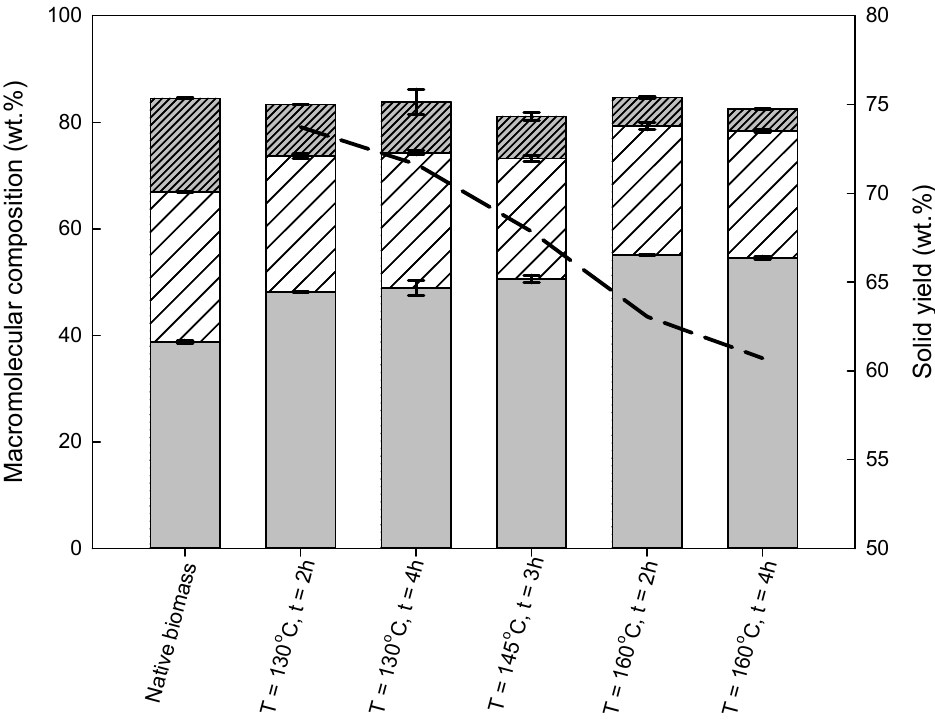
Figure 2. Native wheat straw and solid fraction compositions (wt %), obtained from pre-treatment with imidazole at varied reaction temperatures and times. The black line represents the recovered solids (wt %). The cellulose amount, depicted as a grey bar, was measured in terms of glucan content, and hemicellulose, represented as a white bar with a pattern, was measured as the sum of the xylan and arabinosyl group content. Lignin is depicted as a grey bar with a pattern. Ash and other minor components are not shown, for clarity in the figure.